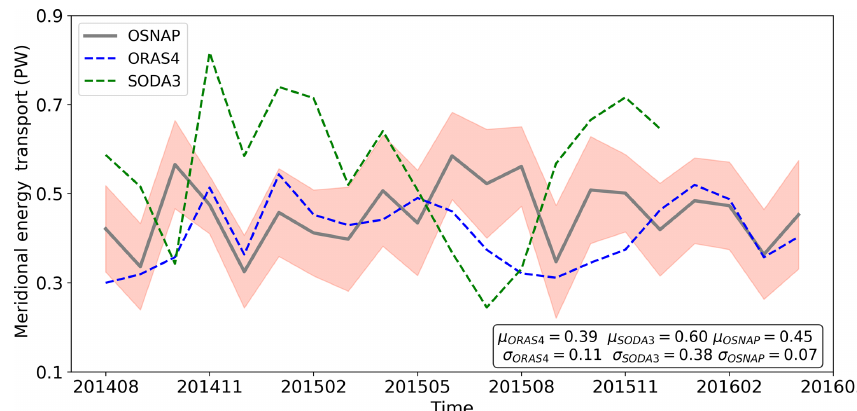
Figure 7. OMET estimated from ORAS4 (blue), SODA3 (green) and compared to the OSNAP observation (gray) at subpolar Atlantic basin. The range of uncertainty from OSNAP observation is marked by the red shade. σ is the standard deviation and µ is the mean of the entire time series.